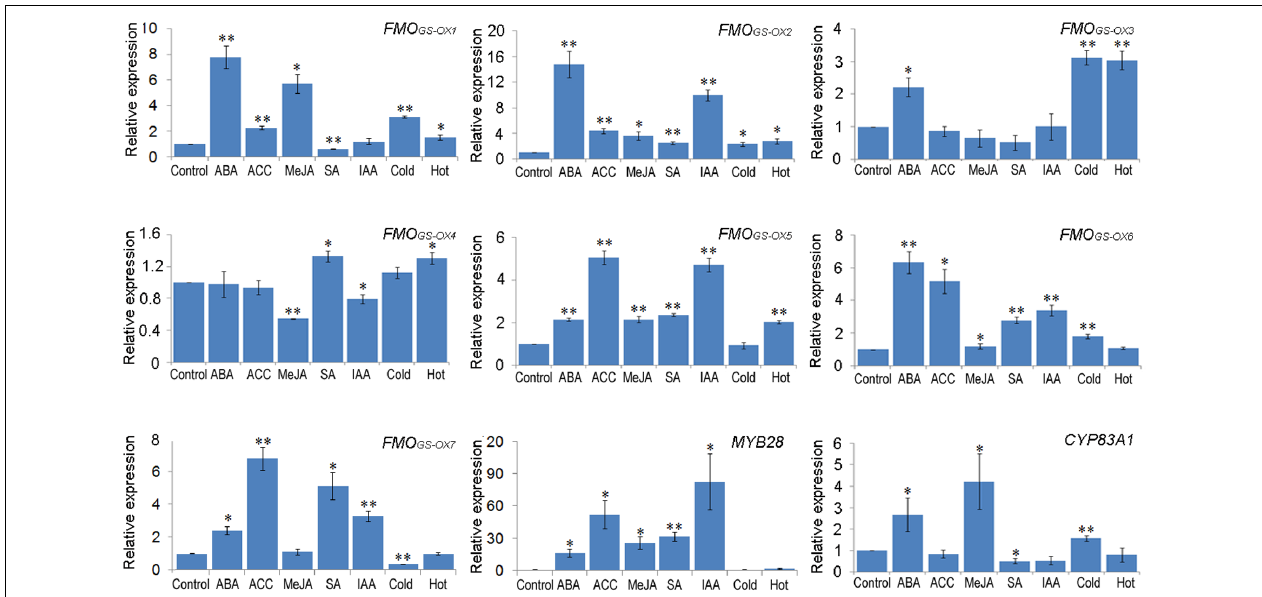
FIGURE 4 | Responsive expression patterns of FMO GS - OX genes to different exogenous stimuli. The mRNA abundance of nine genes was analyzed by qRT-PCR. Samples for qRT-PCR were run in three biological replicates with three technical replicates and the data were represented as the Mean ± SD ( n = 3). The relative gene expression was calculated using the (cid:49)(cid:49) Ct algorithm. The expression data were normalized using the invariant expression of ACTIN II . The leaves from mock control seedlings were used as reference sample, which was set to 1. Significant differences according to Student’s t -test are indicated: ∗ P < 0.05, ∗∗ P <